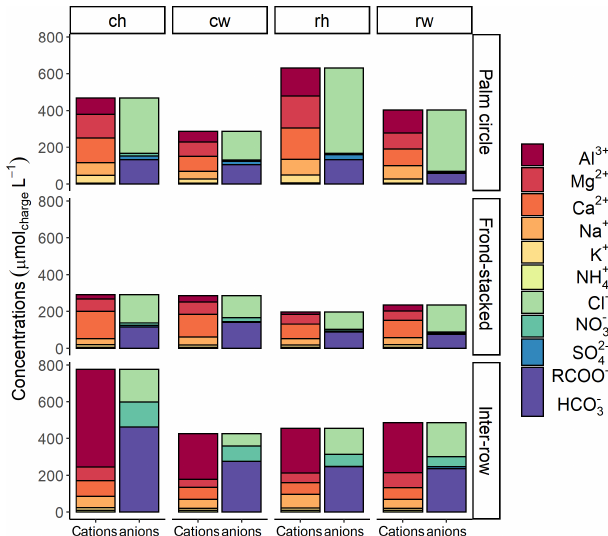
Figure 3. Partial cation–anion charge balance of the major so- lutes (with concentrations greater than 0.03mgL − 1 ) in soil wa- ter at 1.5m depth for each experimental treatment in the different management zones. The combined concentrations of organic acids (RCOO − ) and carbonates (HCO − ) are calculated as the difference 3 between the measured cations and anions. Treatments: ch is con- ventional fertilization–herbicide, cw is conventional fertilization– mechanical weeding, rh is reduced fertilization–herbicide, and rw is reduced fertilization–mechanical weeding.